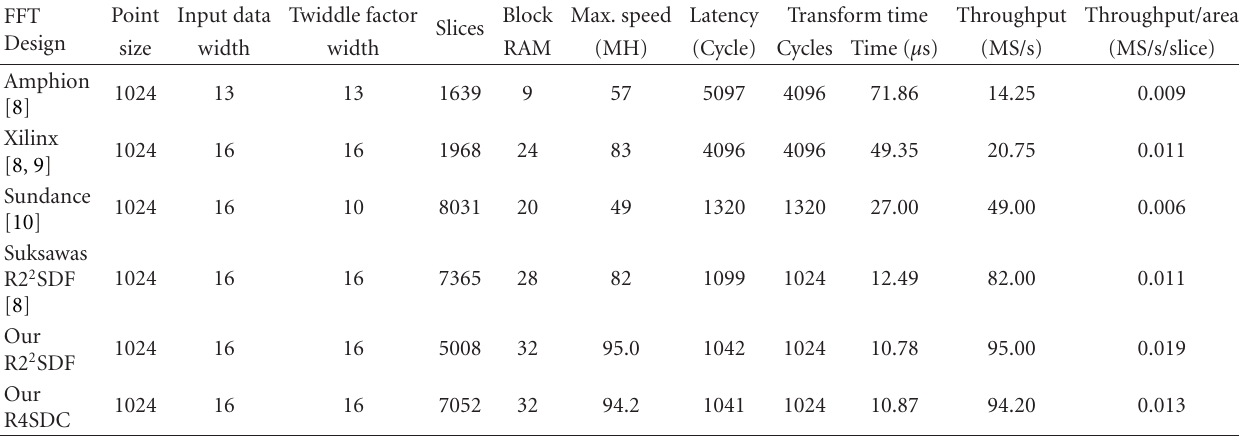
Table 6: Performance comparison versus prior art on Virtex-E devices. FFT